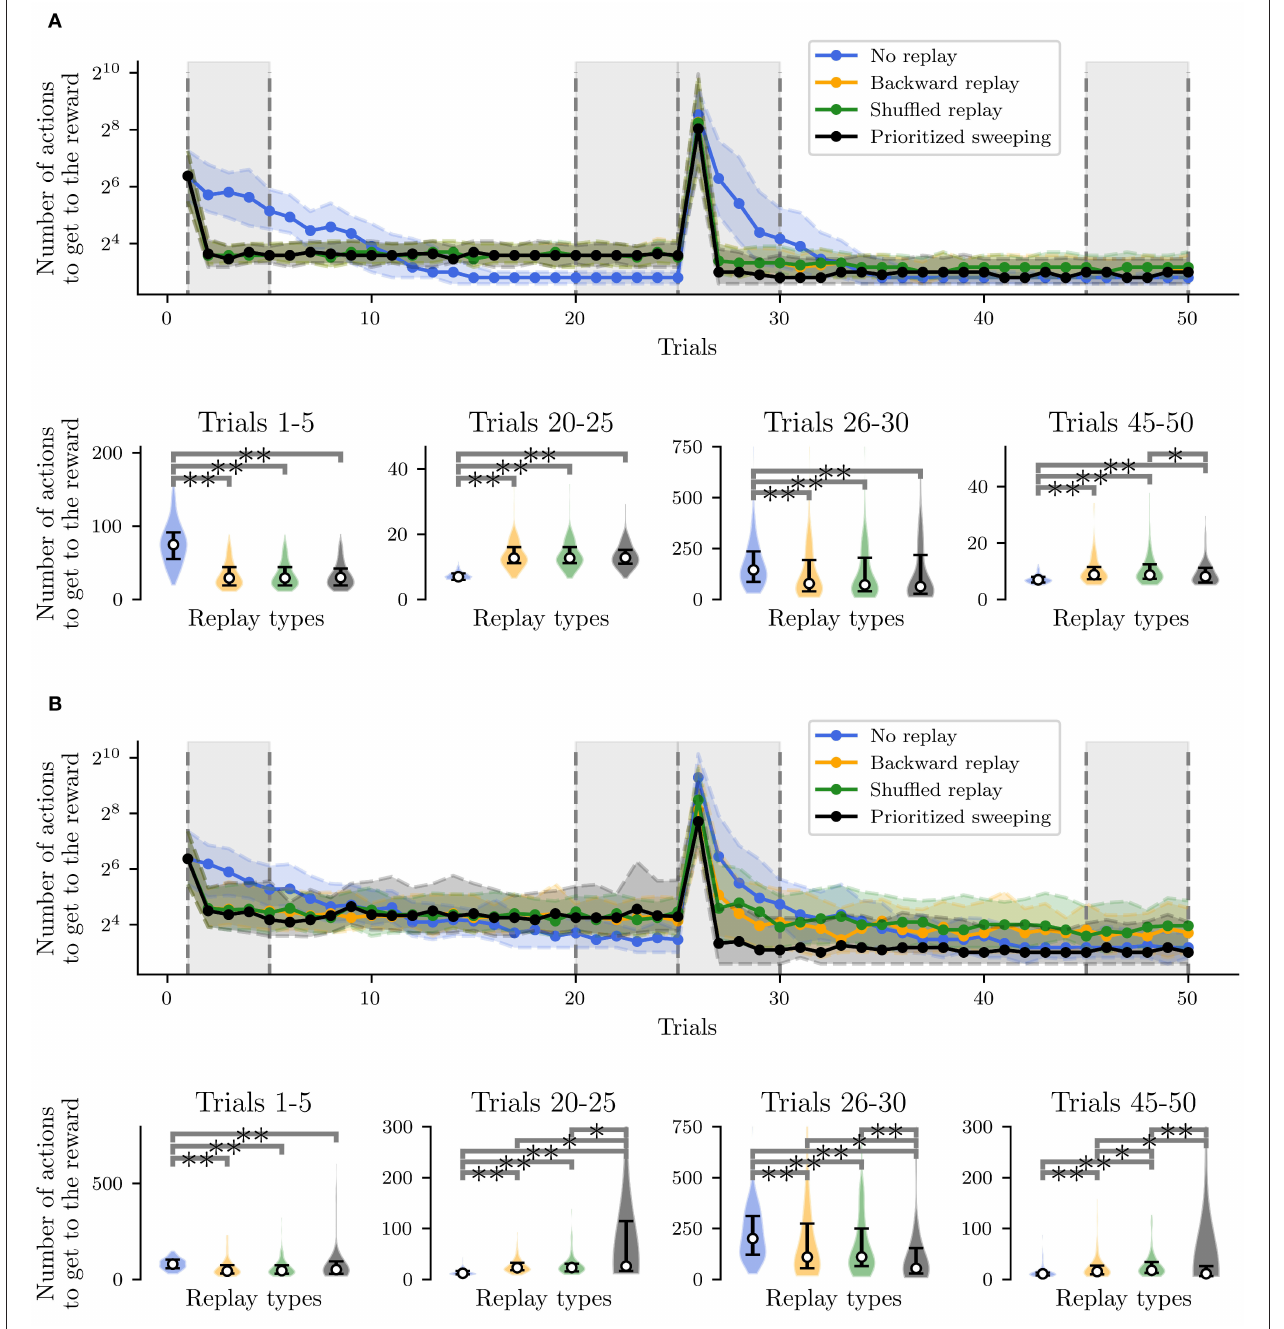
FIGURE 5 | Performances of the simulated robot, learning the non-stationary task, and a post-hoc Wilcoxon-Mann-Whitney pairwise comparison test on the relevant trial intervals among the different curves. The post-hoc test has been performed following a Kruskal-Wallis H -test (Kruskal and Wallis, 1952) to reject the null hypothesis that the population median of all of the algorithms’ average performances was equal. ** Stands for p -value lower than 0.001 and * for p -value lower than 0.05. (A) Deterministic environment. (B) Stochastic environment.